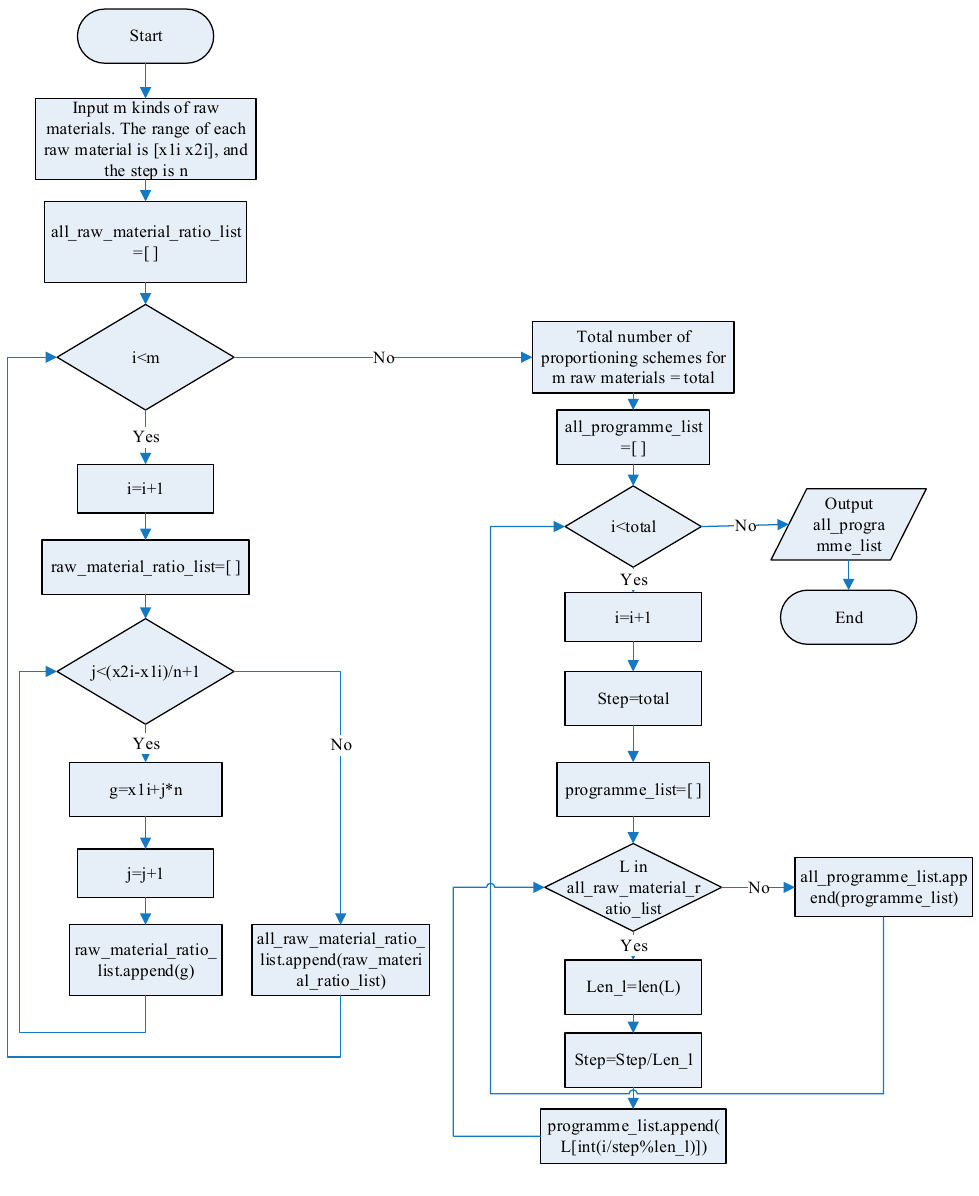
Figure 1. Algorithm flow chart.